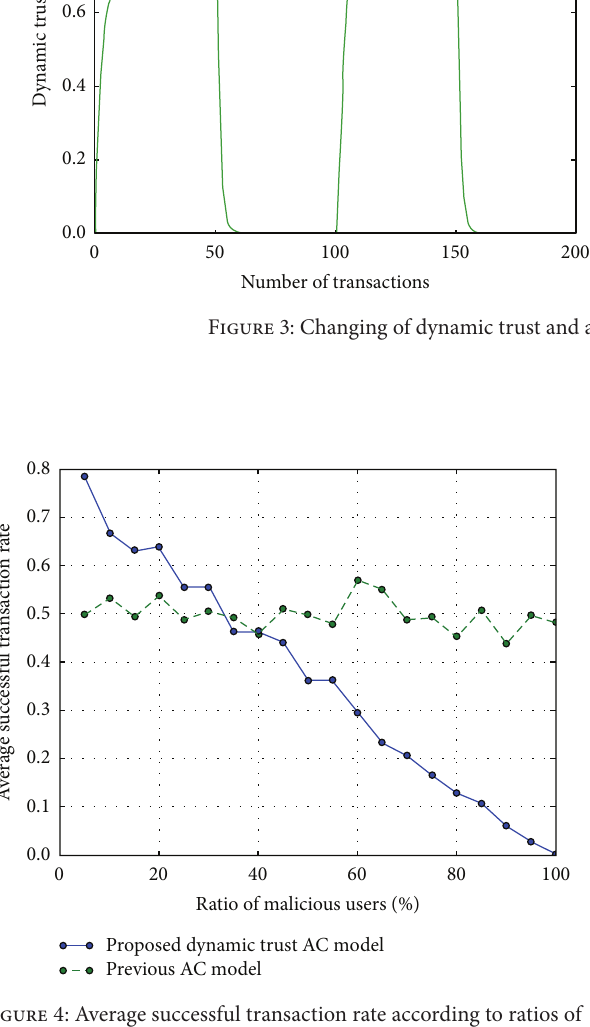
Figure 4: Average successful transaction rate according to ratios of malicious